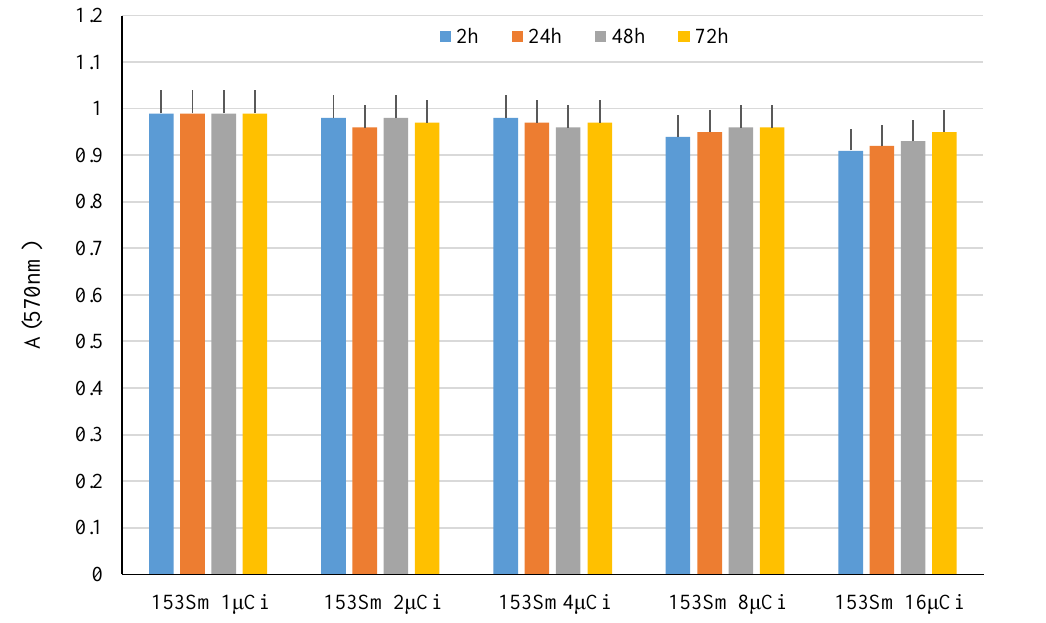
Figure 5A. Effect of 153 SmCl3 on viability of SW480